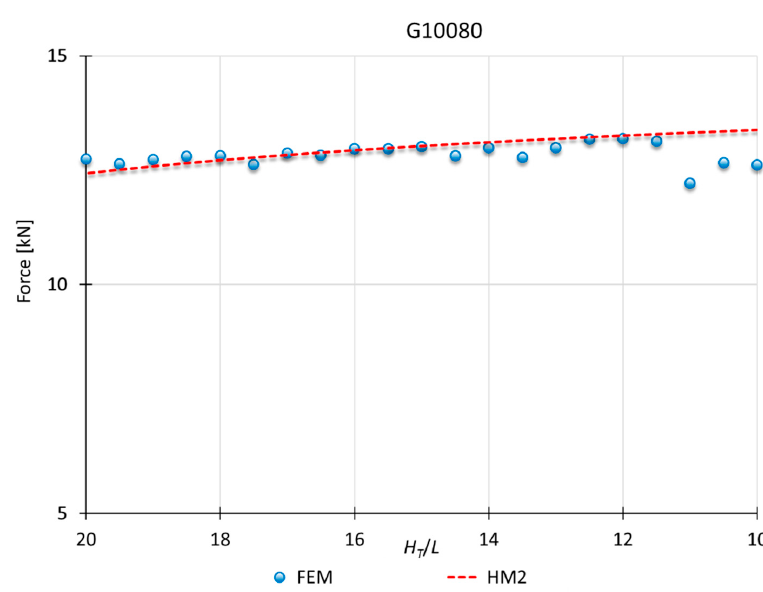
Figure 11. MUBT-FEM comparison for G10080, n = 0.17.